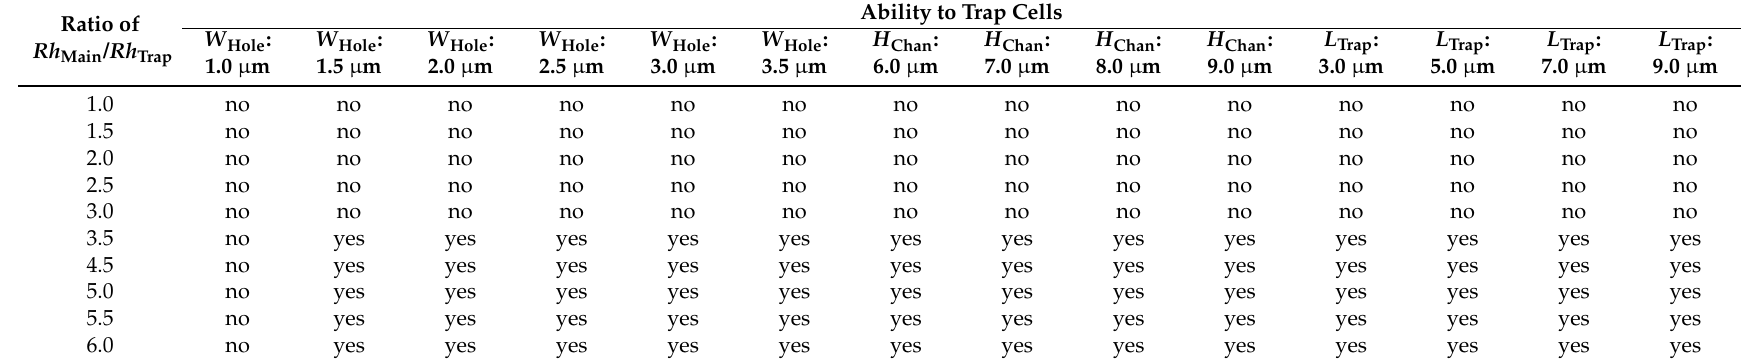
Table 1. Cell trapping results for different single-cell trapping model with different sizes of W hole , H chan , and L Trap and various Rh Main / Rh Trap . Ratio of Rh Main / Rh